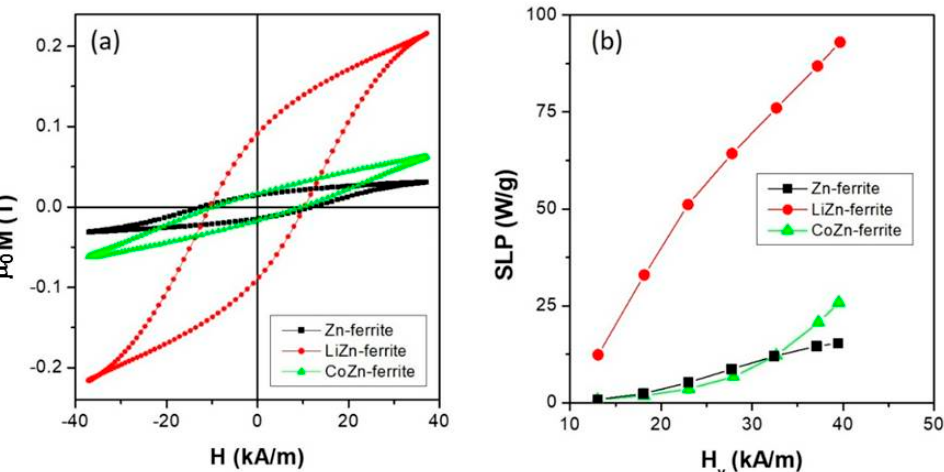
Figure 3. ( a ) Room-temperature minor ac-hysteresis loops of all the studied samples (f = 69 kHz and H v = 37 kA/m); ( b ) specific loss power (SLP) values for all the samples as a function of the vertex field obtained by the ac-hysteresis loops areas.